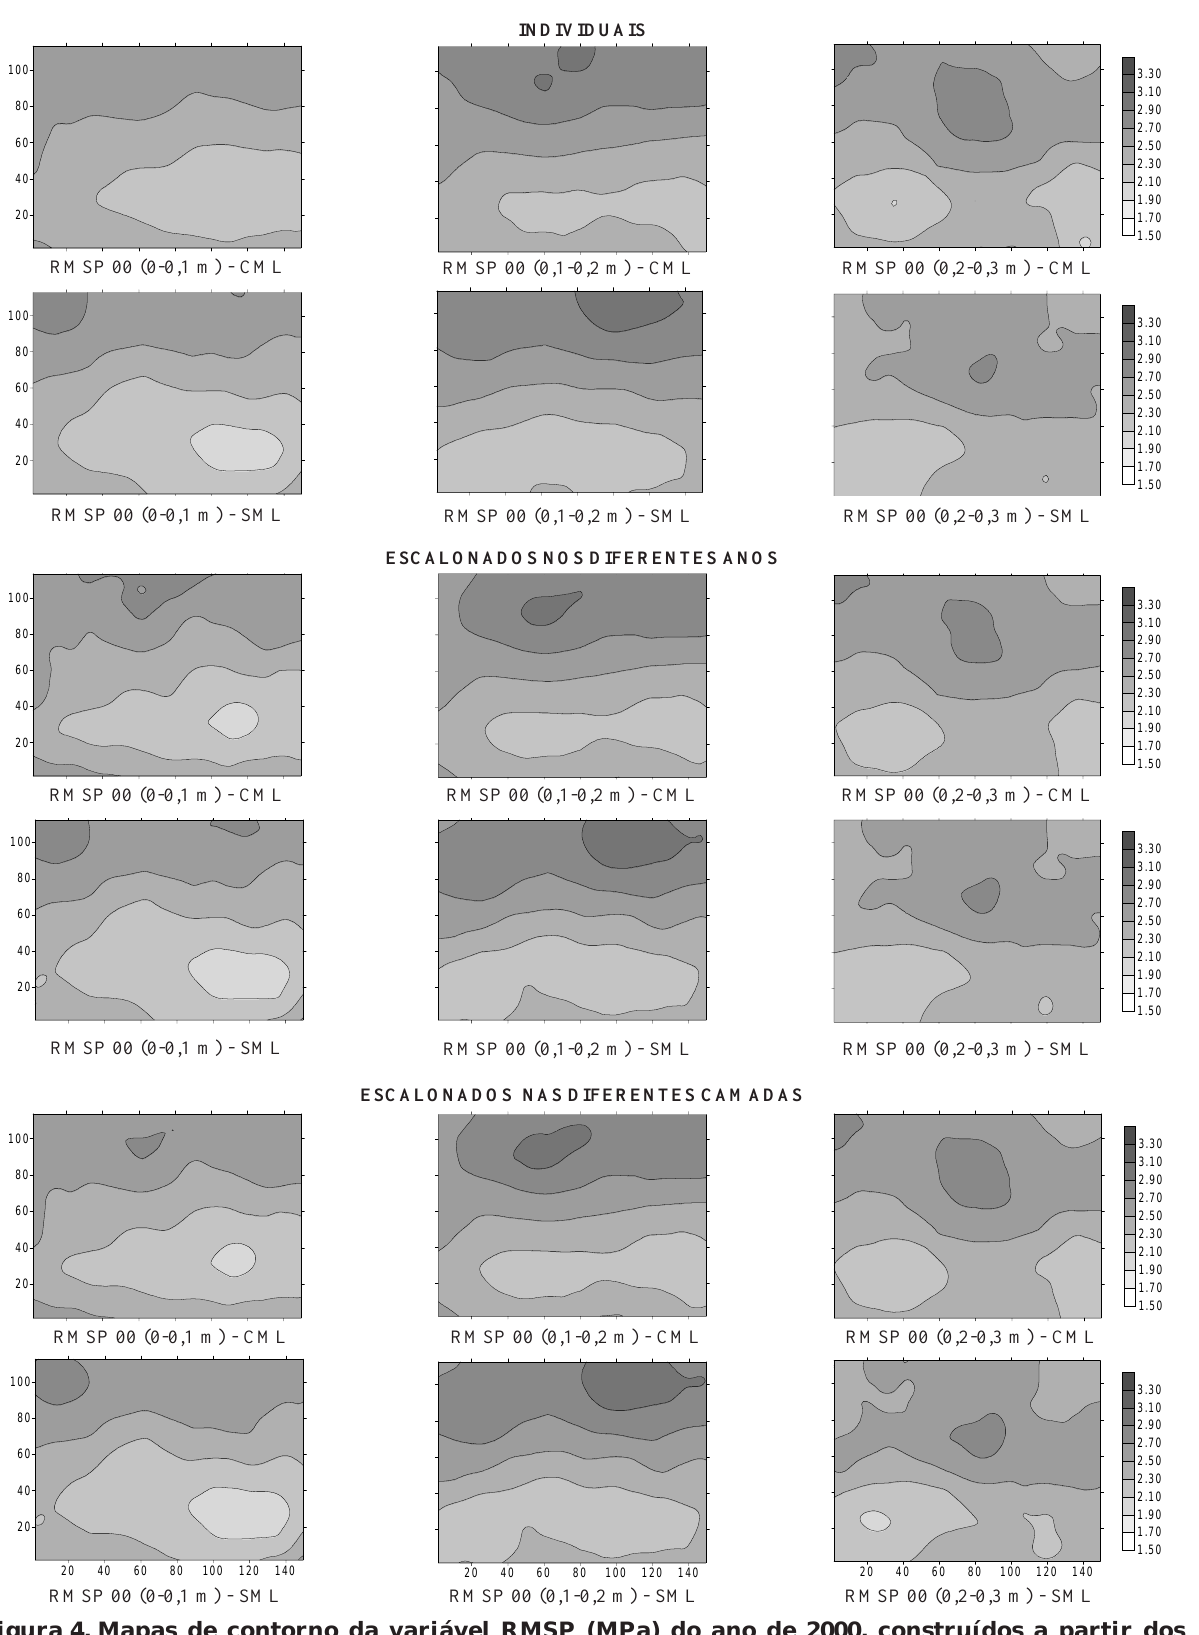
Figura 4. Mapas de contorno da variável RMSP (MPa) do ano de 2000, construídos a partir dos semivariogramas individuais; escalonados nos diferentes anos de amostragem e nas diferentes